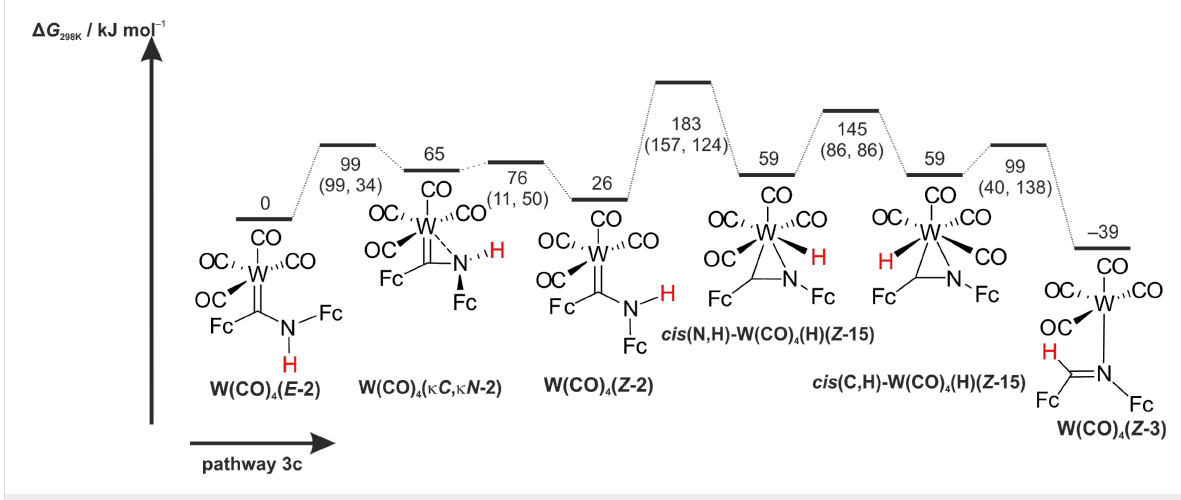
Figure 1: DFT calculated oxidative addition/pseudorotation/reductive elimination pathway 3c from W(CO) 4 ( E -2) to W(CO) 4 ( Z -3) .